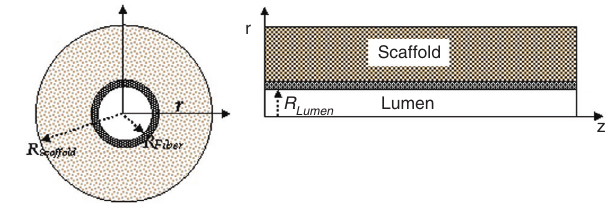
Figure 10 Velocity profile comparison between finite element simulation and analytical solution [49].